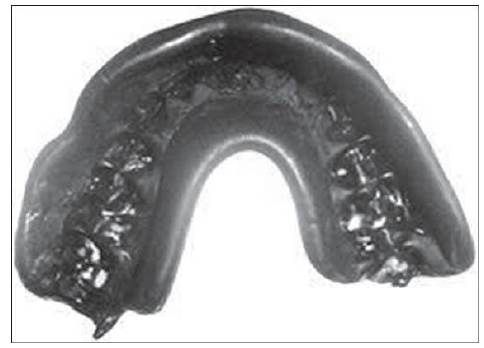
Figure 6. A mouth-formed mouthguard (“boil and bite” mouthguard) [47].